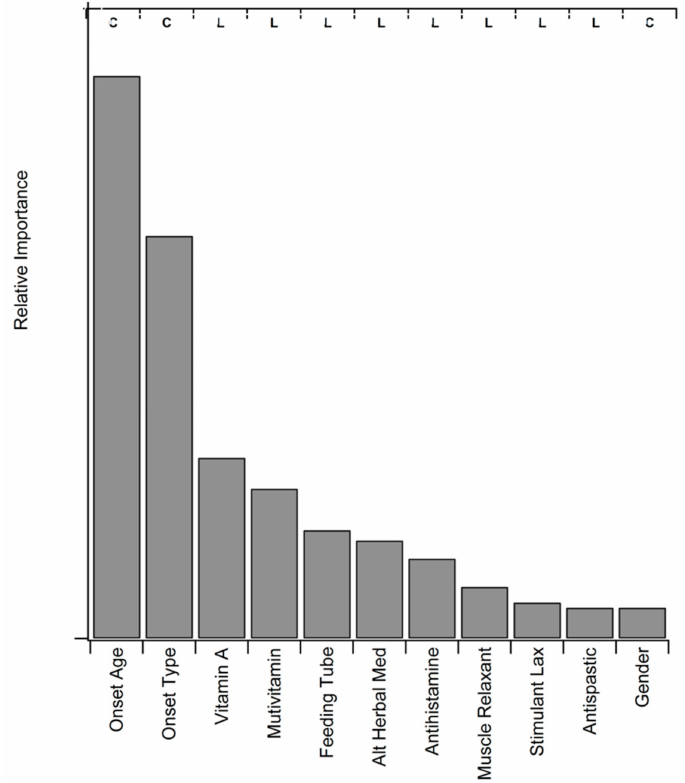
Figure 4. Pharmaceuticals & supplements and patient characteristics as predictors of ALS disease duration. Conditional random forests were used to determine how much each individual metric helped increase the area under the curve (AUC), the primary metric of model performance prediction. Relative importance is normalized and scaled for ease of visualization. Note that “feeding tube” represents nutritional supplements given via a percutaneous endoscopic gastrostomy (PEG).”C” denotes that the factor is a patient characteristic versus a medication, and “L” represents that the medication or supplement is more strongly associated with longer survival